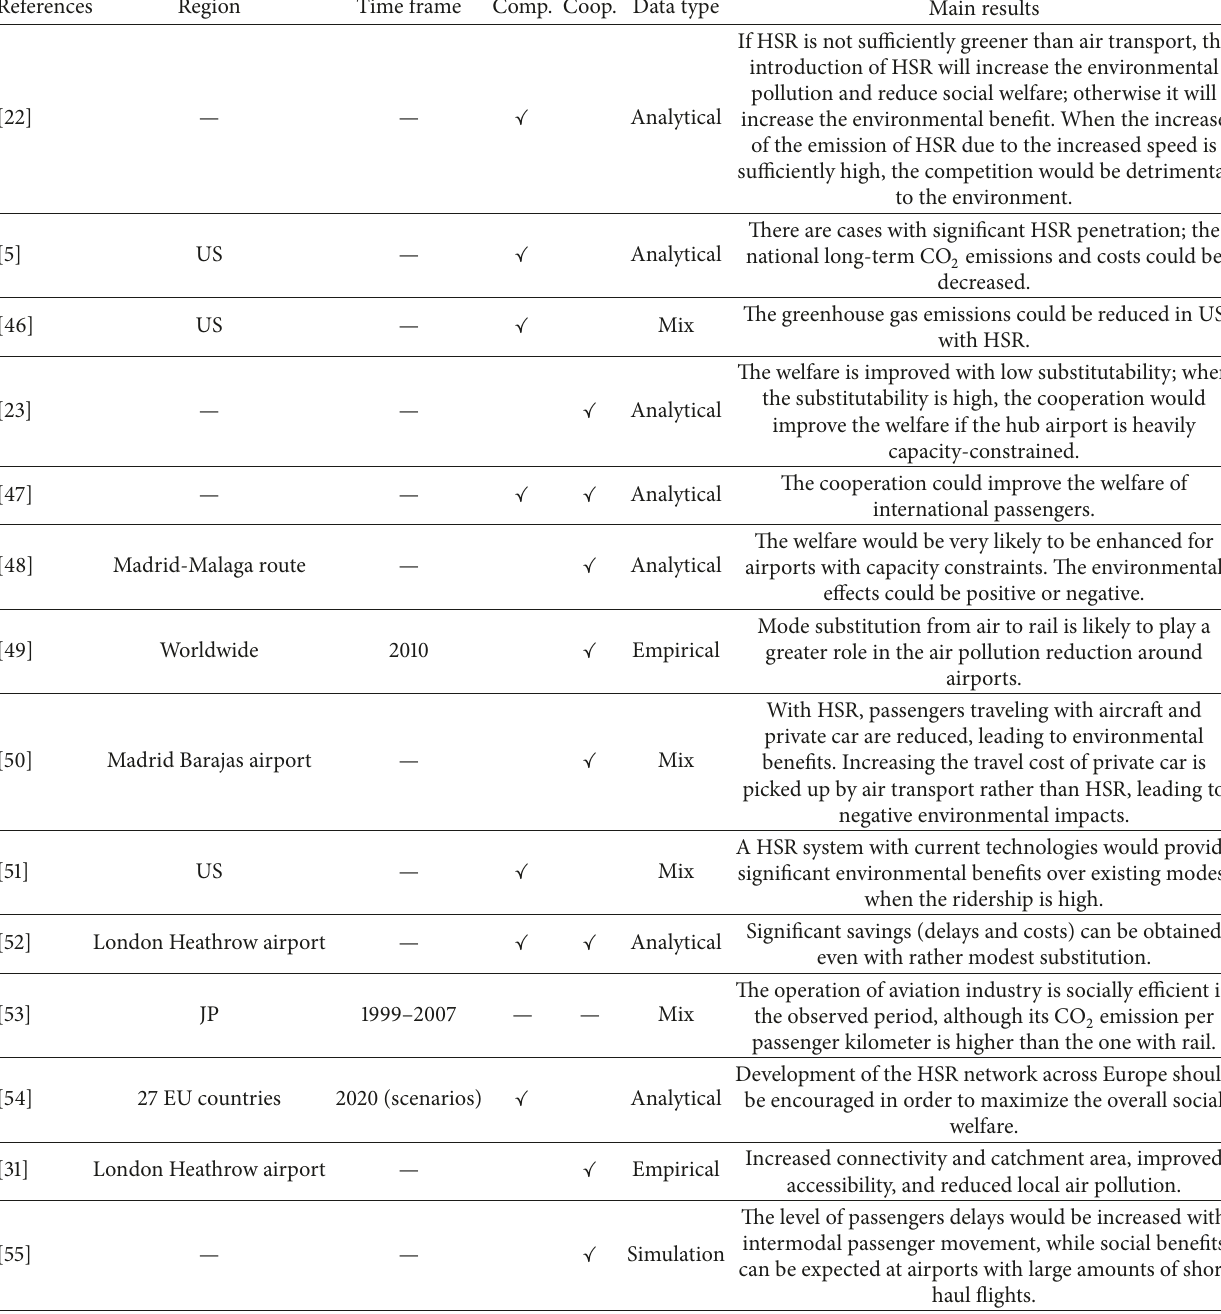
Table 9: The competition and cooperation effects between air transport and HSR on environment and social